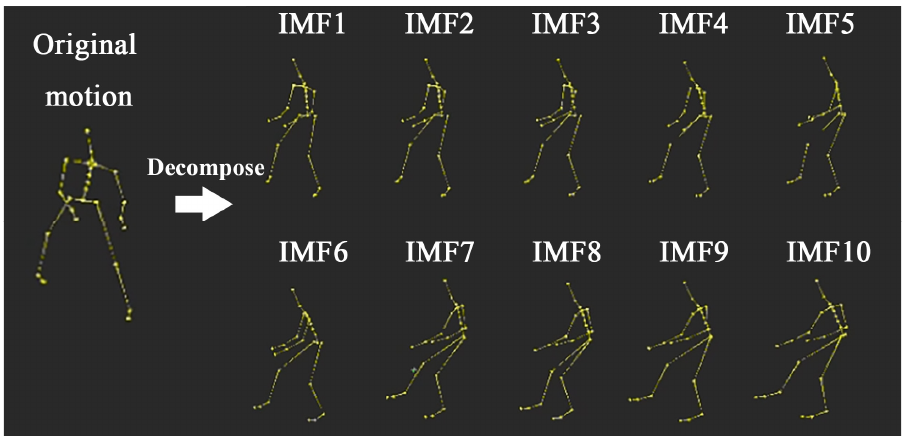
Figure 4. An Example of the Mowing Motion Decomposition.